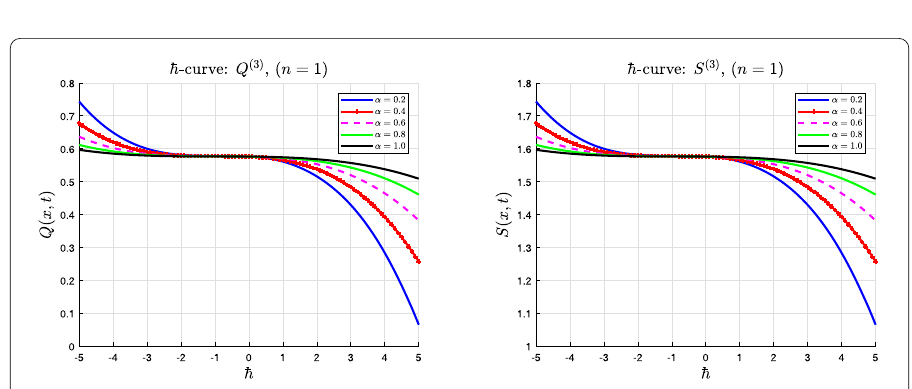
Figure 20 (cid:2) -curves plot with different α when k = 0.1, λ = 1.5, x = 10, and t = 0.1 for Example 4.2